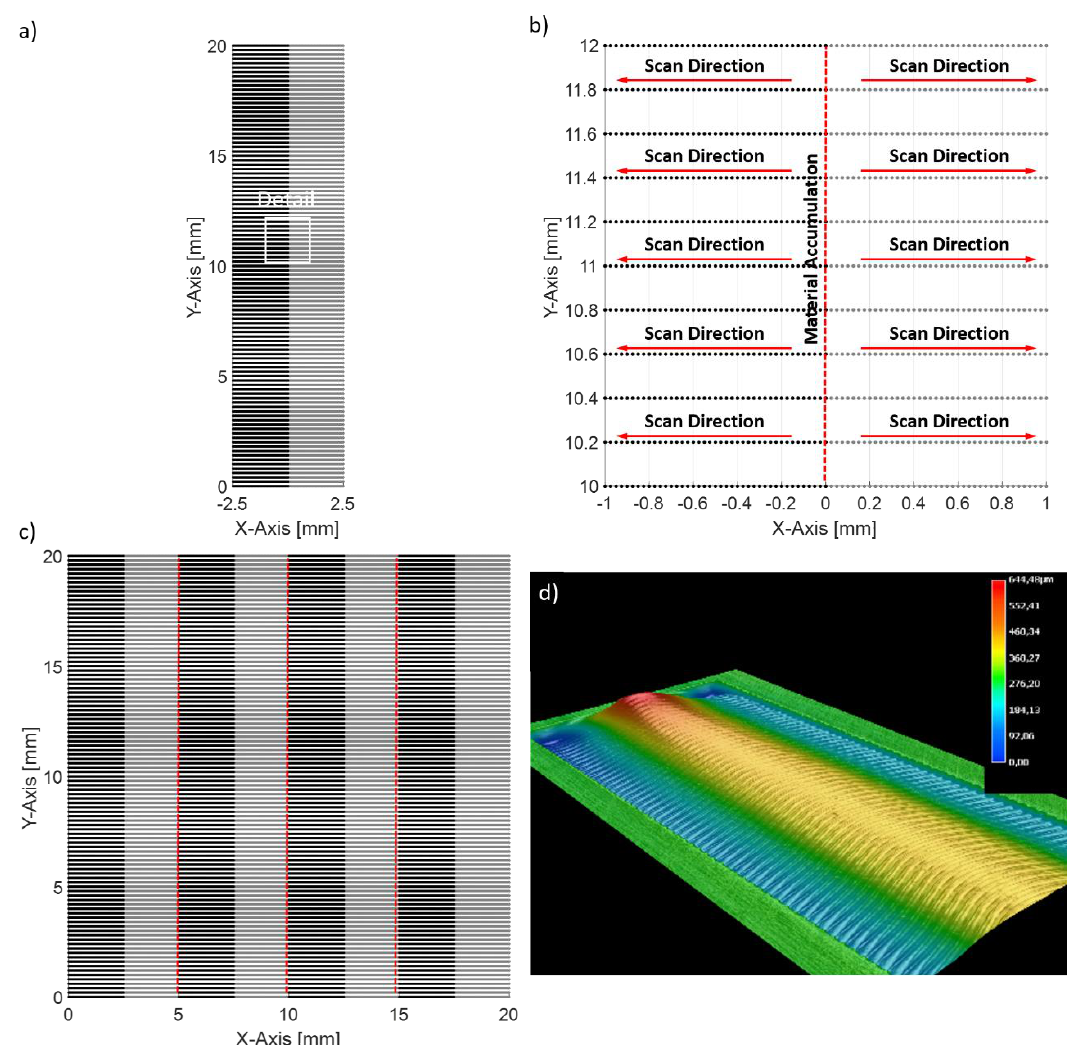
Figure 3 . ( a ) Electron Beam scan strategy followed to produce the bridge structures (B). ( b ) detail